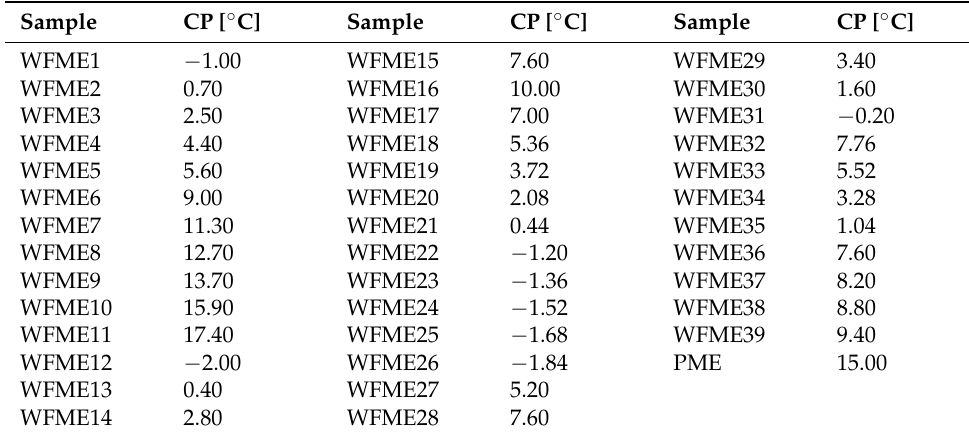
Table 6. Cloud point (CP) values for all biodiesel samples.